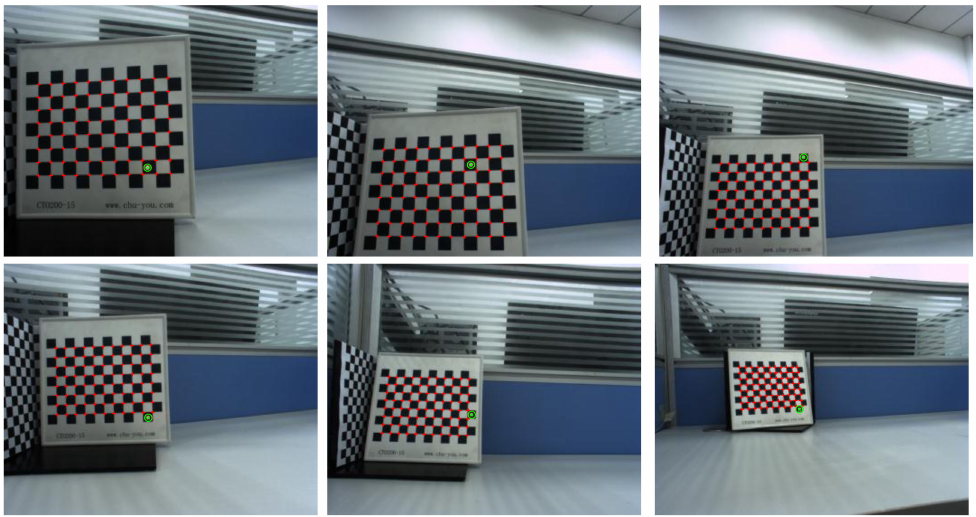
(cid:104) (cid:105) R l 2 M t l 2 M .